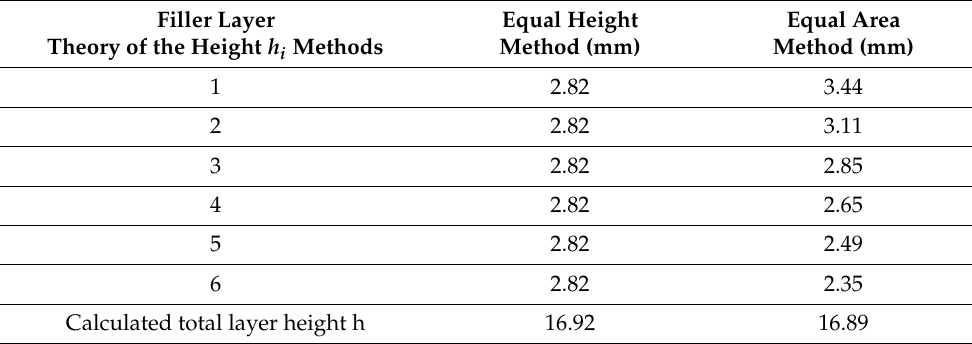
Table 1. Layer height of theoretical filling layer with a pipe diameter of 1219 mm. Filler